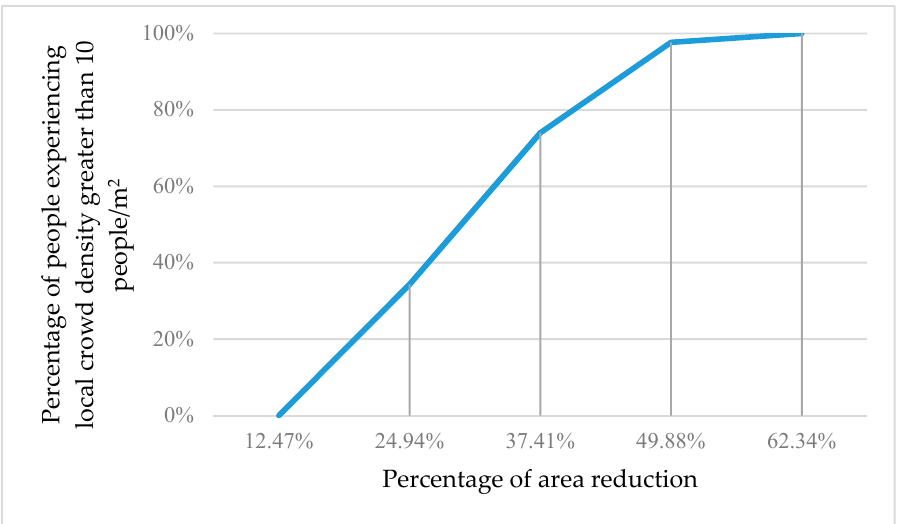
Figure 10. The percentage of people experiencing local crowd density greater than 10 people/m 2 as the occupied area shrinks.